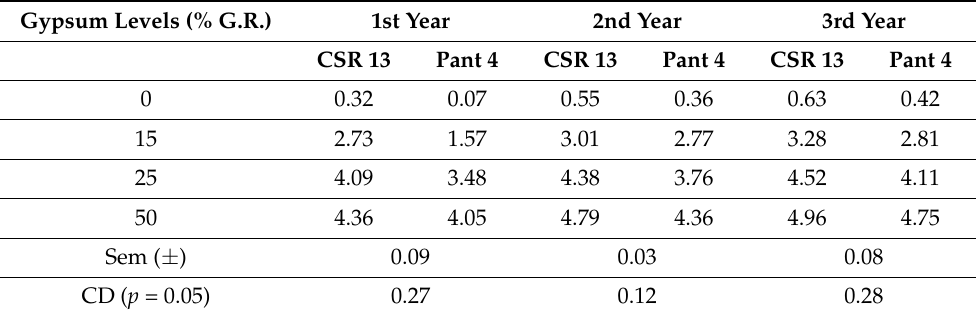
Table 1. Combined effect of gypsum levels and varieties on grain yield (t/ha − 1 ) of rice. Gypsum Levels (%